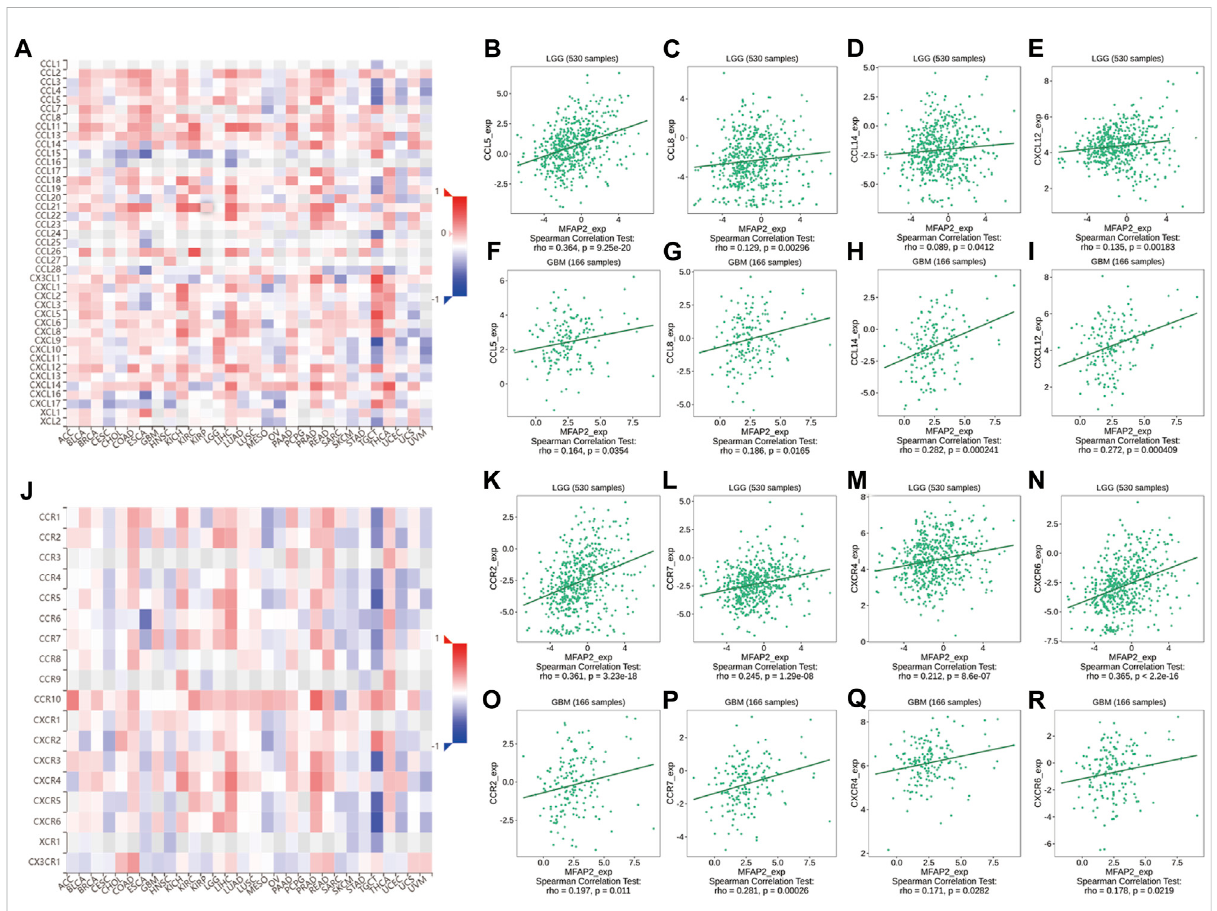
FIGURE 5 Correlation between MFAP2 expression and chemokines or chemokine receptors in glioma from the TISIDB database. (A) Relevance between MFAP2 expression and chemokines in 30 tumors, including LGG and GBM. (B – E) Relevance between MFAP2 expression and chemokines (CCL5, CCL8, CCL14, and CXCL13) in LGG. (F – I) Correlation between MFAP2 expression and chemokines (CCL5, CCL8, CCL14, and CXCL13) in GBM. (J) Correlation between MFAP2 expression and chemokine receptors in 30 tumors, including LGG and GBM. (K – N) Correlation between MFAP2 expression and chemokine receptors (CCR3, CCR7, CXCR4, and CXCR6) in LGG. (O – R) Correlation between MFAP2 expression and chemokine receptors (CCR3, CCR7, CXCR4, and CXCR6) in GBM. Color images are available